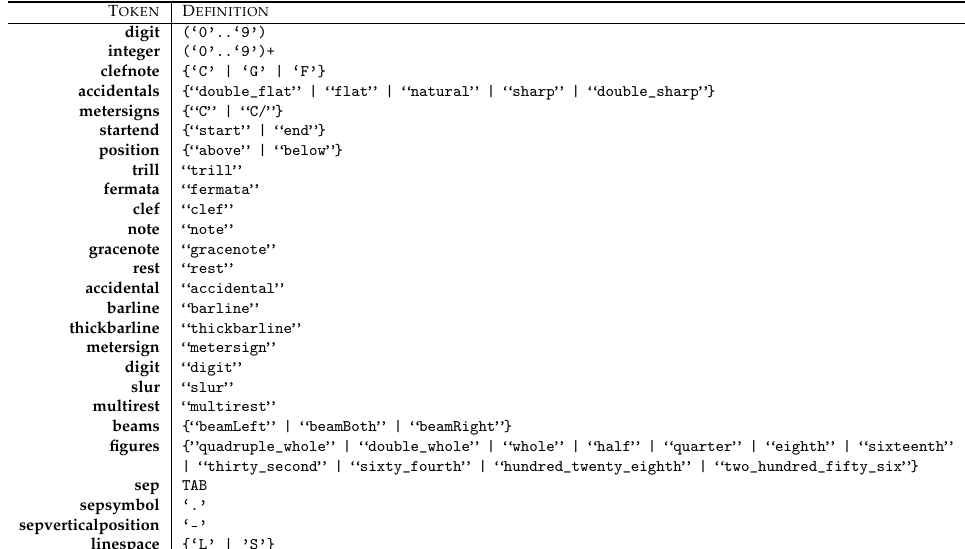
Table A3. Lexical rules for the agnostic